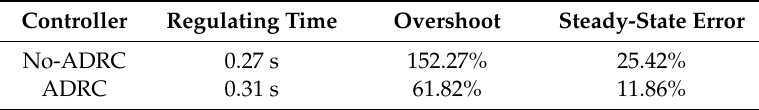
Figure 17. Simulation curve of the electromagnetic torque.